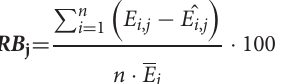
FIGURE 1 | Schematic illustration indicating the pure chemostatic behavior (solid line) for which solute concentration does not change with increasing discharge. In this scenario, changes in solute export are proportional to increases in water export. Divergences above the line represent the transport-limited scenario for which stream solute concentration increases with increasing discharge. This pattern emerges as additional sources get hydrologically connected within the catchment and solutes are flushed toward the stream. Near- and in-stream biological demand may occur but could be exceed by solute supply. Divergences below the line correspond to the solute-limited scenario for which solute concentration decreases with increasing discharge. This pattern can emerge when solute sources within the catchment become exhausted, solute are taken up by biota, or both. In this case, near- and in-stream biological demand could exceed